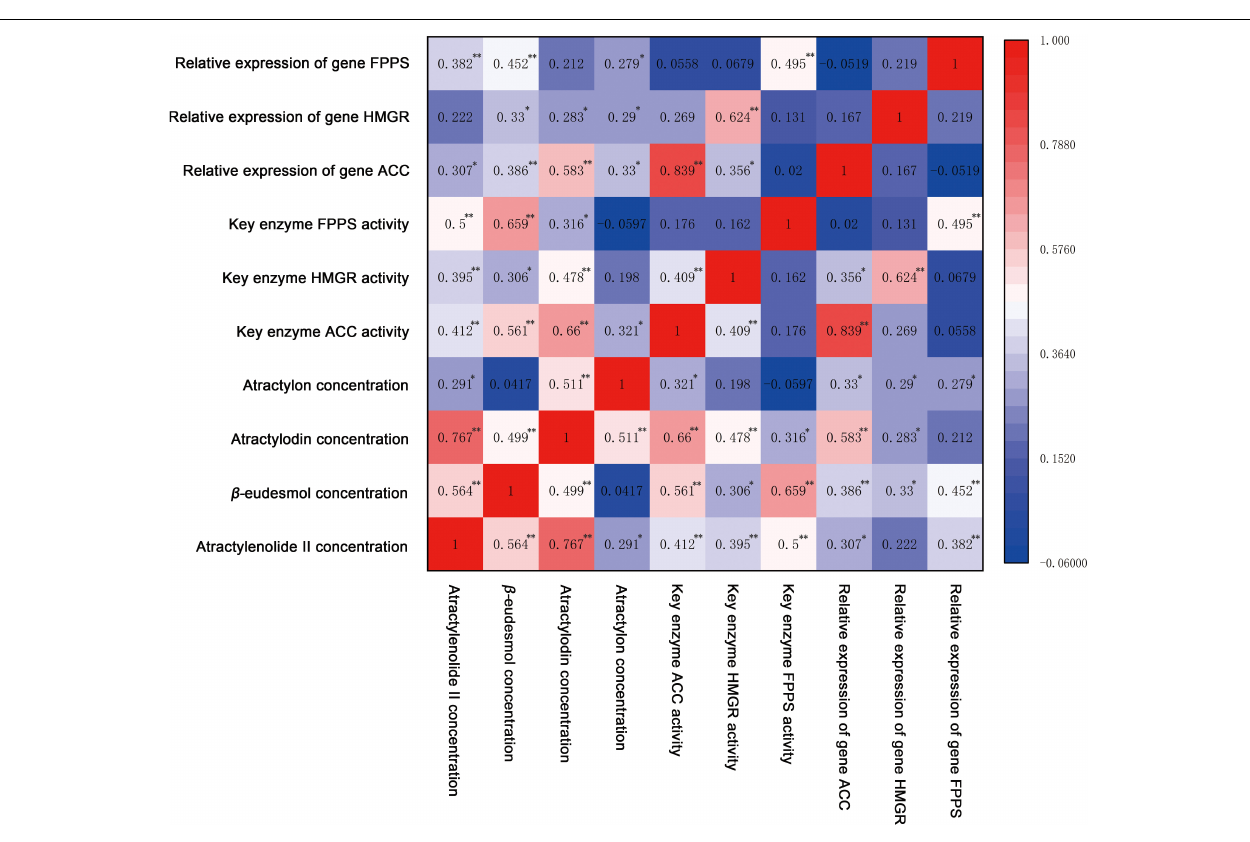
enzymes ACC, HMGR, FPPS, and the relative expression of